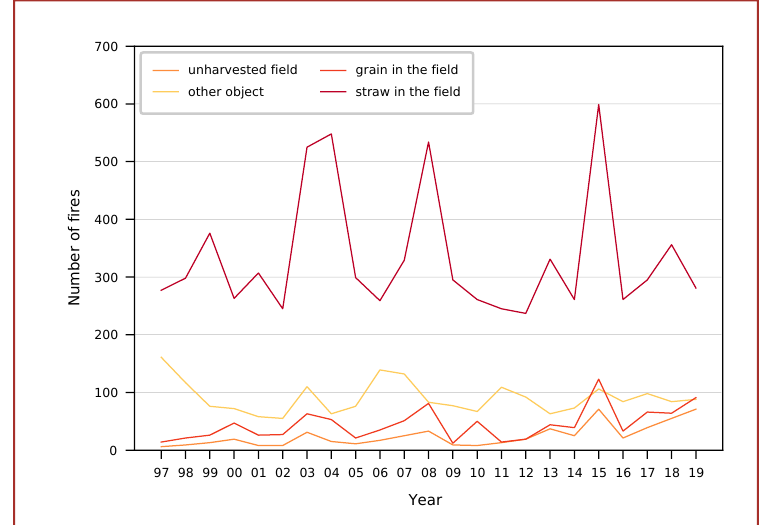
Figure 9. Various kinds of field fires in the Czech Republic.